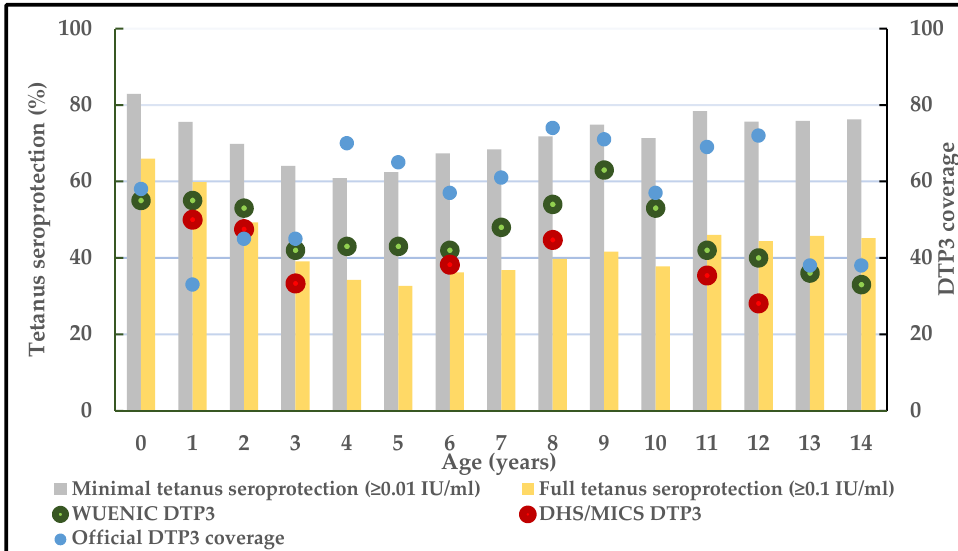
Figure 5. Triangulation of tetanus seroprotection and DTP3 vaccination coverage among children aged <15 years, Nigeria, 2018. WUENIC: WHO/UNICEF estimates of national immunization coverage; DTP3: 3 doses of diphtheria-tetanus-pertussis vaccine; DHS: Demographic and Health Survey; MICS: Multiple Indicator Cluster Survey.